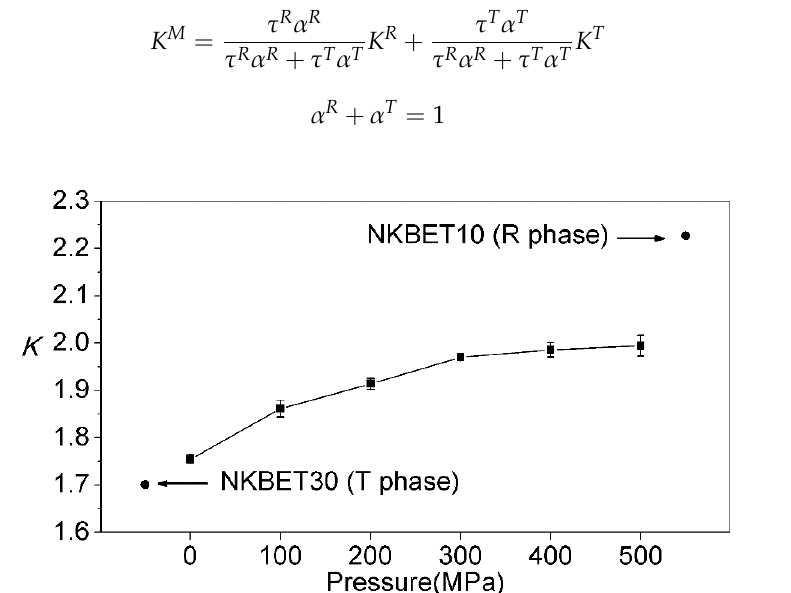
→ 7 F → 7 F transition to the 5 D transition of 0 2 0 1 D F  transition to the 5 7 D F  transition 0 2 0 1 K